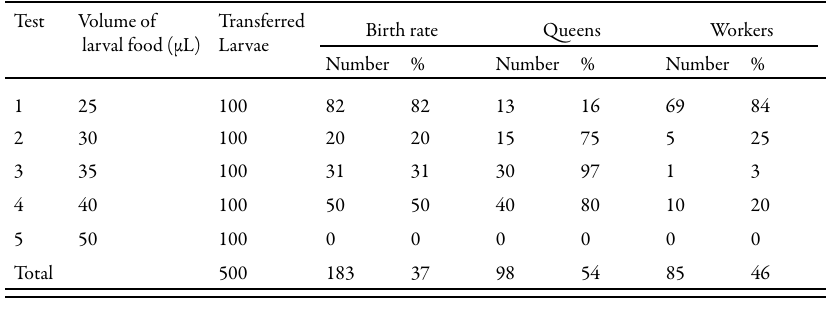
Table 2 : Transference of Frieseomelitta varia larvae to the in vitro production of queens with different amounts of larval food (µL) and their respective survival rates (%).